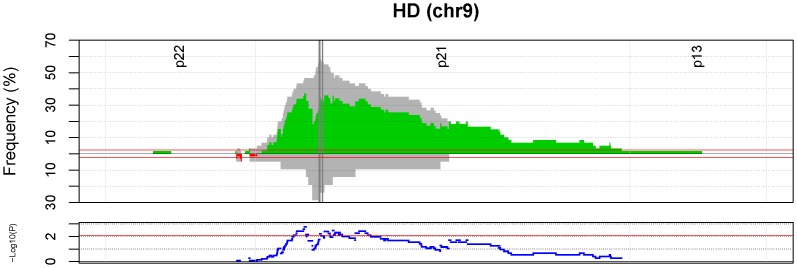
Frequency of homozygous deletion at chr9.p21, among UMU samples.The samples are split into two groups, based on their genotype at the EGFR variant rs1015793. HD frequency among samples homozygous for the major allele is plotted on the upper half of the upper panel (grey bars), and the HD frequency among samples homozygous for the rare allele plus heterozygous samples is plotted on the lower half of the upper panel (grey bars). The frequency difference between the groups is illustrated with overlaying red and green bars. The event frequency cutoff is illustrated by the horizontal red lines. The dark grey, vertical lines represent CDKN2A and CDKN2B. The lower panel illustrates the p-values (−log10 transformed) at each genomic site, with the horizontal red line illustrating the permutation derived p-value cutoff (0.0085).